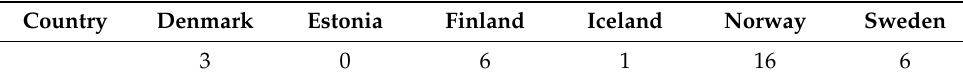
Table 1. Number of papers from each country at the conference. Country